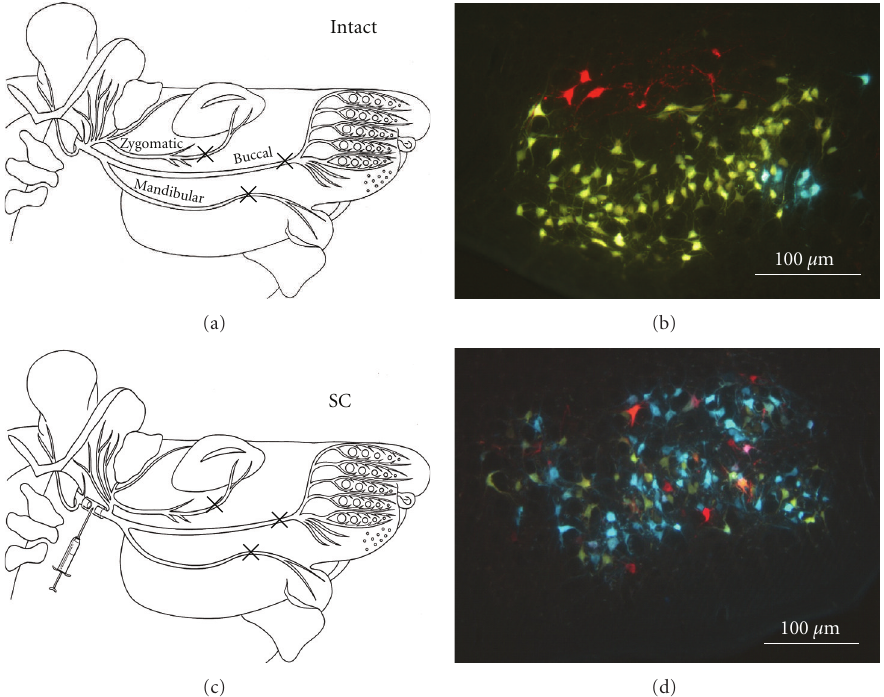
Figure 3: Myotopic organization of the facial nucleus and collateral axonal branching as estimated by the pattern of retrograde labeling. In intact animals, simultaneous application of DiI ( red ), FG ( yellow ), and FB ( blue ) to the zygomatic, buccal and mandibular nerve branches, respectively, labels distinct subnuclei with no overlap (a), (b). Two months after entubulation with collagen or collagen plus SC the myotopic organization is lost irrespective whether the animals received MS (c), (d).